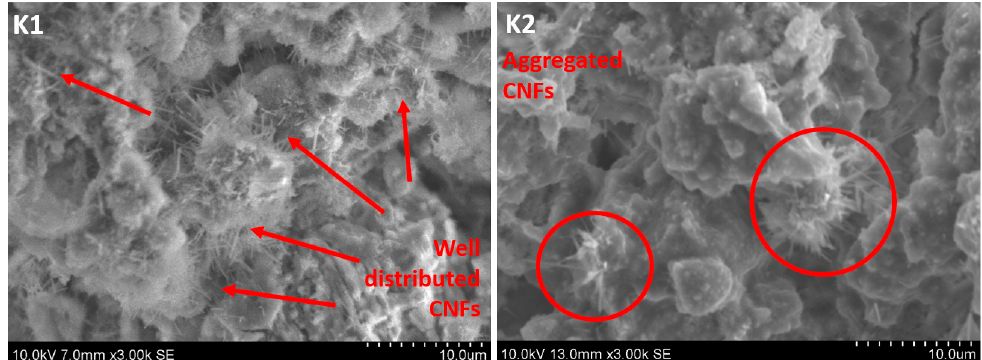
Figure 5. SEM (SE) images showing topography of K1 ( top ) and K2 ( bottom ) surface in contact with steel electrode ( left ) and surface of a fracture ( right ).